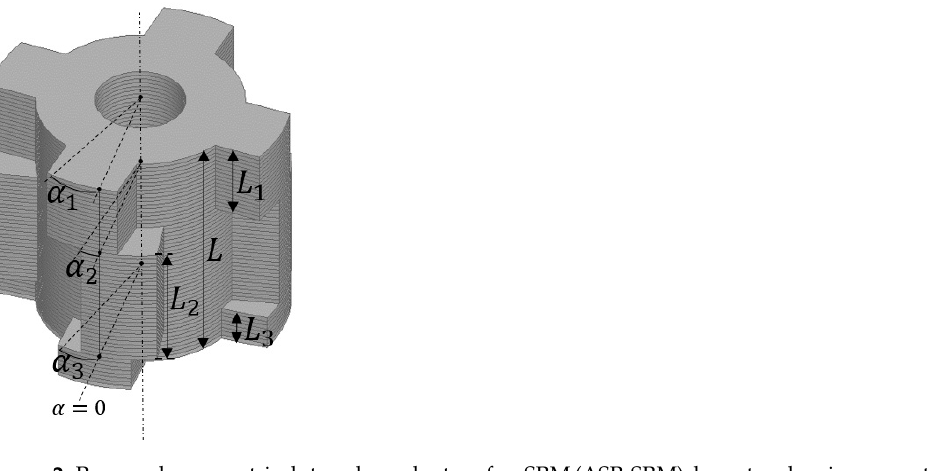
Figure 2. Proposed asymmetrical step-skewed rotor of an SRM (ASR-SRM): layout and main